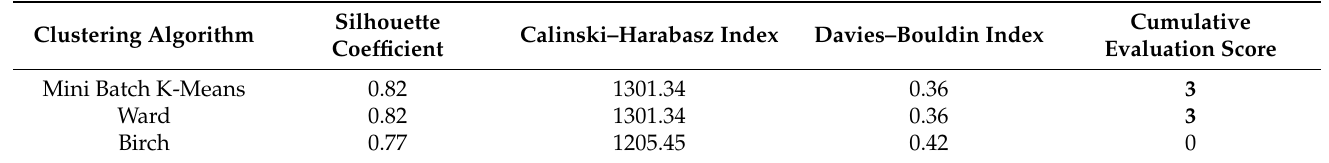
Table 2. Evaluation of clustering methods for CS2. The best evaluation score is shown in bold.